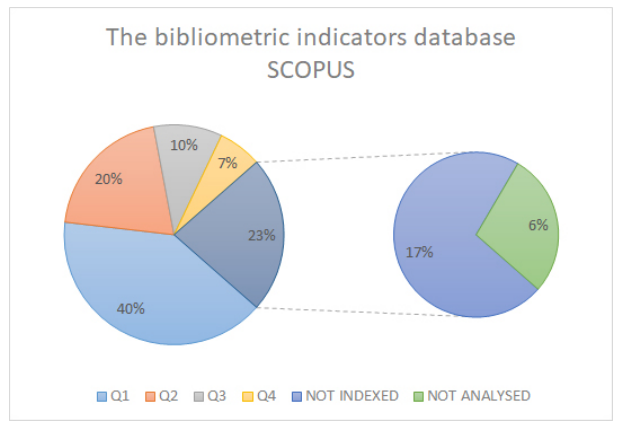
Figure 4. SCOPUS database bibliometric indicators.